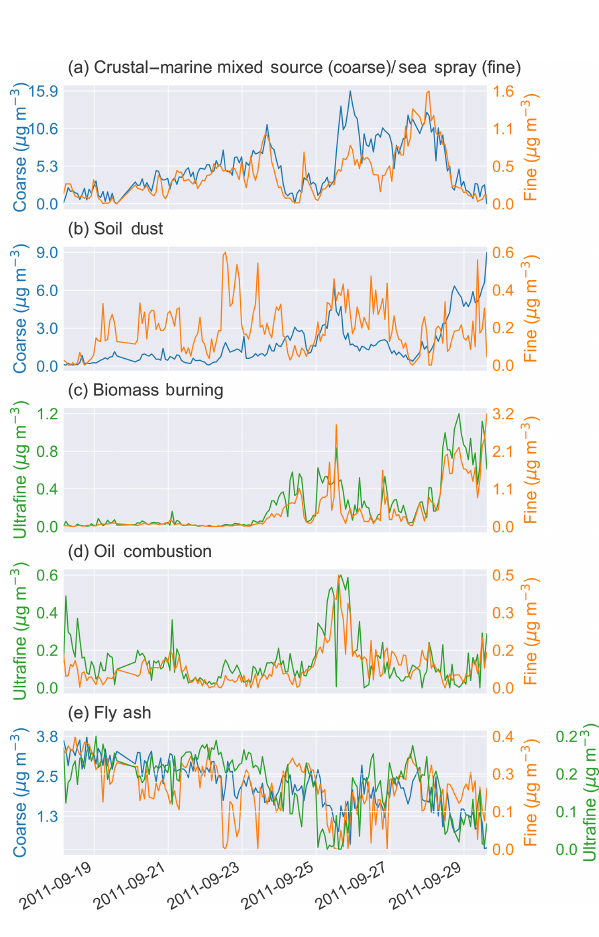
Figure 7. Temporal distribution of PMF source contributions (µgm − 3 ) for (a) crustal–marine mixed source, (b) soil dust, (c) biomass burning, (d) oil combustion, and (e) fly ash. Coarse: stage 1–3 (1.15–10µm; blue); fine: stage 4–6 (0.34–1.15µm; or- ange); ultrafine: stage 7–8 (0.10–0.34µm;